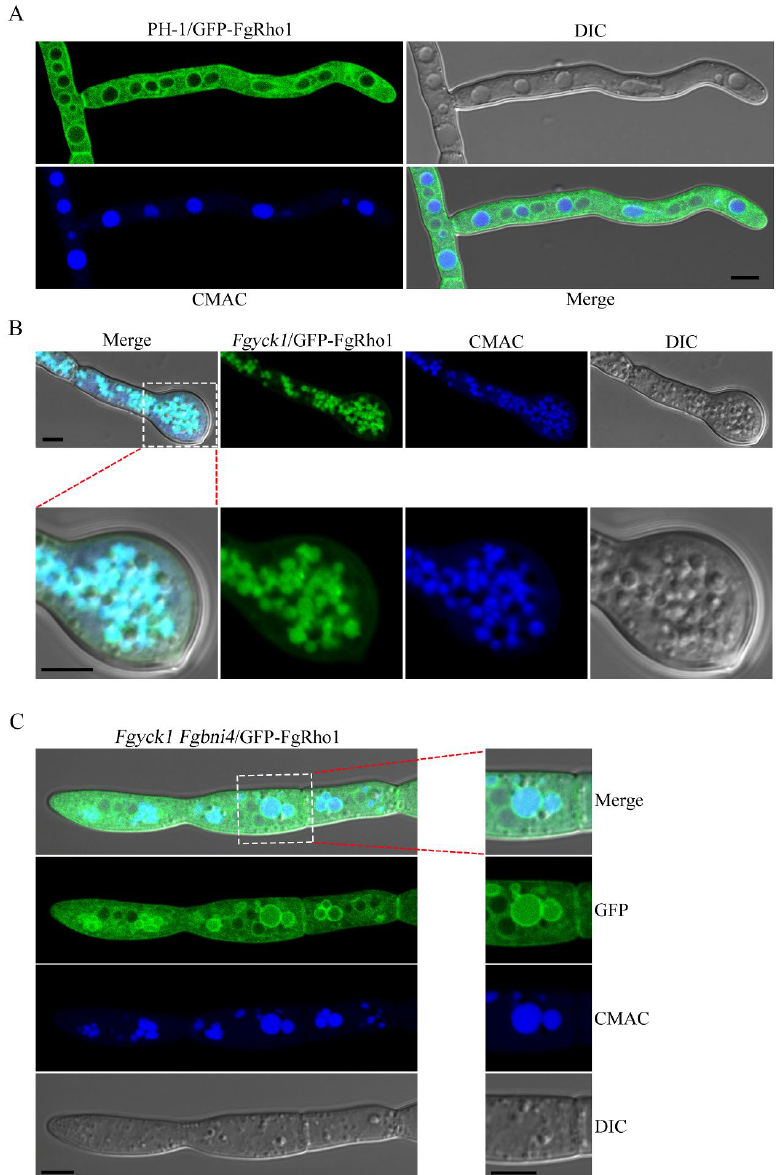
Figure 7. Localization of GFP-FgRho1 in the wild type, Fgyck1, and Fgyck1 Fgbni4 strains. ( A ) Hyphae of GFP- FgRHO1 transformant of the wild-type strain PH-1. ( B ) Representative germ tubes of Fgyck1 mutant expressing GFP- FgRHO1 . The lower panels are close-up views of the swollen tip as marked. ( C ) Hyphae of Fgyck1 Fgbni4 /GFP- FgRHO1 transformant. The right panels are close-up views of the framed sections on the left. For all the strains, hyphae were harvested from 12 h YEPD cultures and examined by confocal microscopy. The CMAC dye was used to stain the vacuolar lumen. Bar, 5 µ